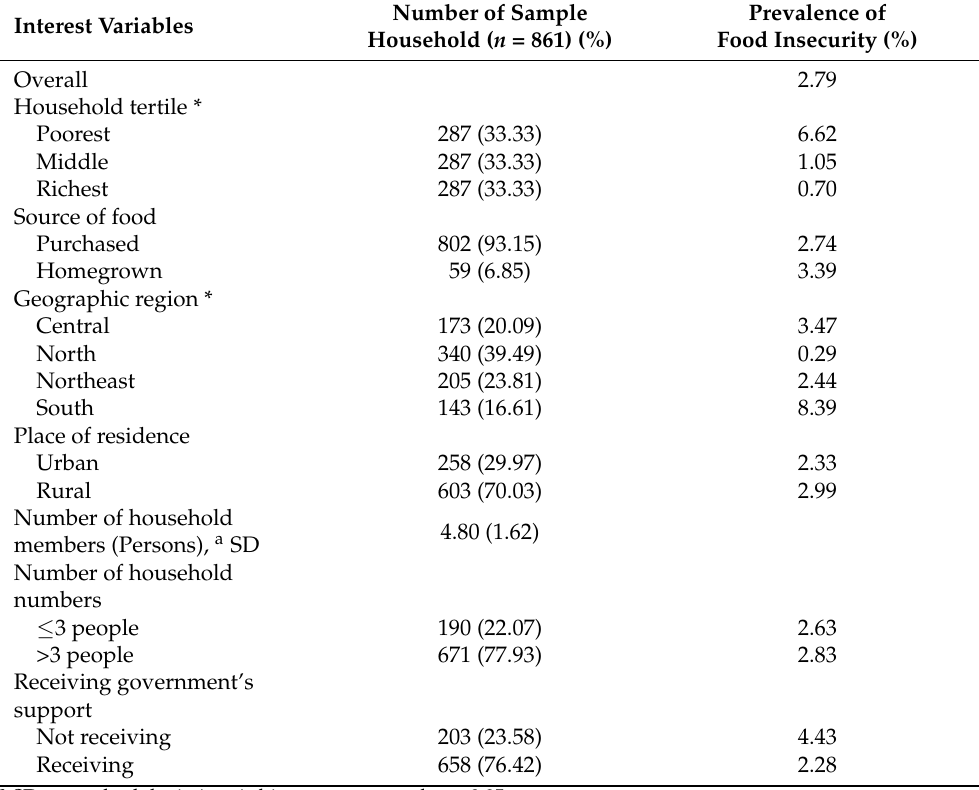
Table 2. Characteristics of sample household and distribution of prevalence of food insecurity.